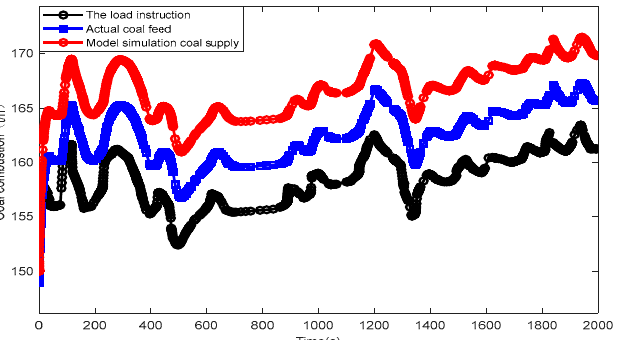
Figure 8. The simulation and the actual values of the coal quantity based on the actual coal instruction.